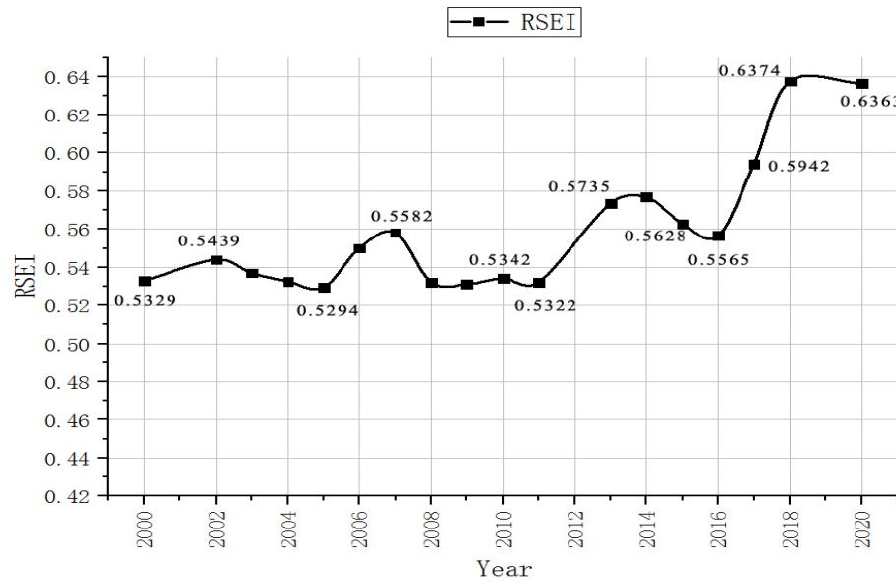
Figure 3. Mean RSEI value during 2000–2020.